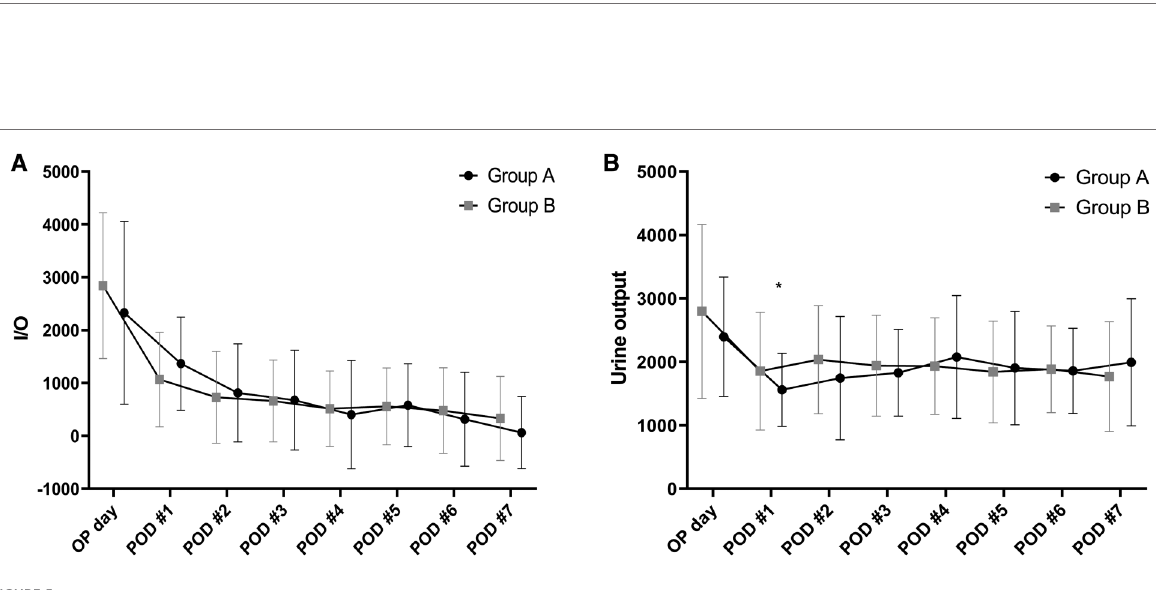
FIGURE 5 Between-group comparisons in daily fl uid balances ( A ) and urine outputs ( B ) in the perioperative period. There are no signi fi cant differences in the daily fl uid balances between the two groups. However, daily urine outputs are signi fi cantly lower in the patients with LVDD than in those with Normal LV diastolic function at postoperative day 1 (1,560±577 vs. 1,853±928, P =0.038) and day 2 (1,744±971 vs. 2,036±853, P =0.024). * P <0.05, LVDD, left ventricular diastolic dysfunction; LV, left